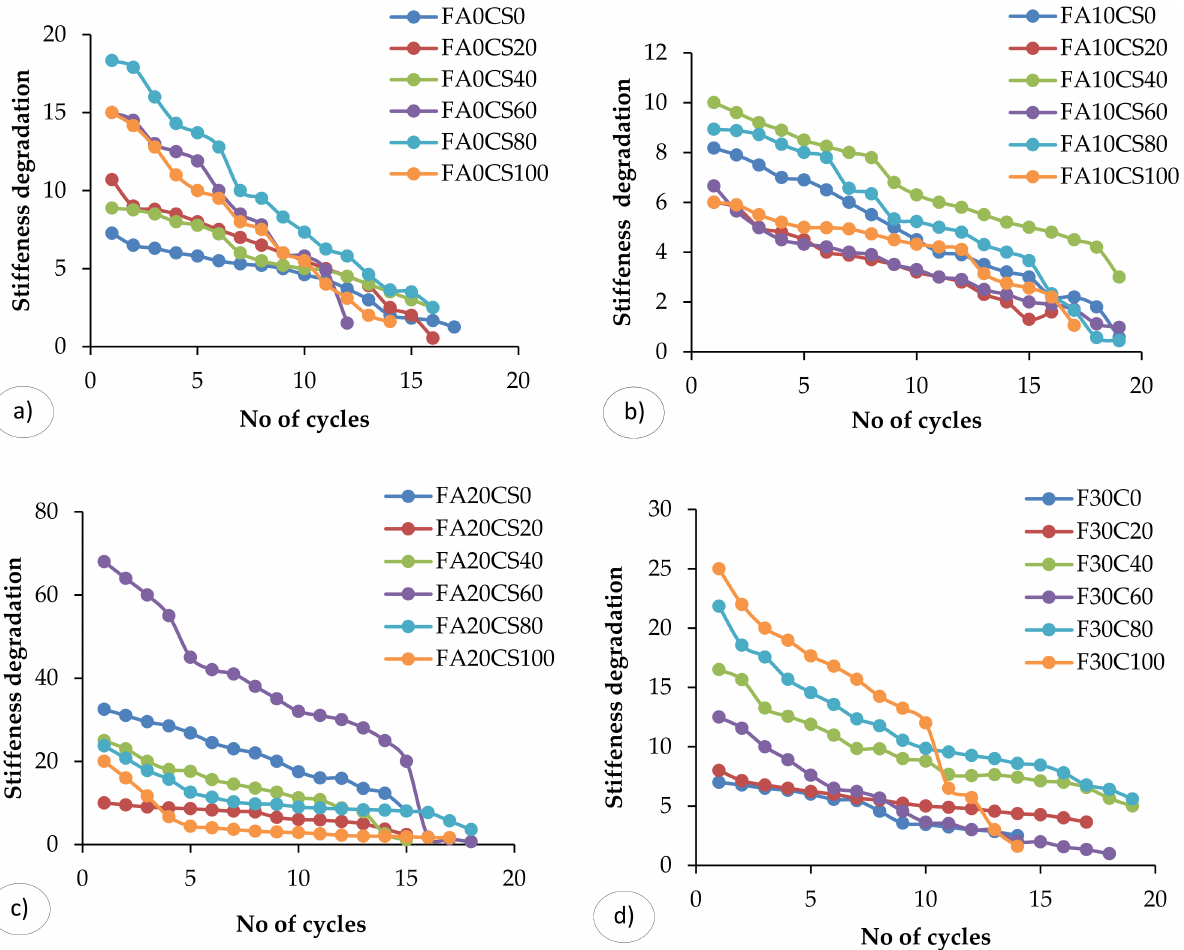
Figure 9. Stiffness degradation versus no. of cycles: ( a ) 0%FA and 0–100%CS, ( b ) 10%FA and 0–100%CS, ( c ) 20%FA and 0–100%CS, ( d ) 30%FA and